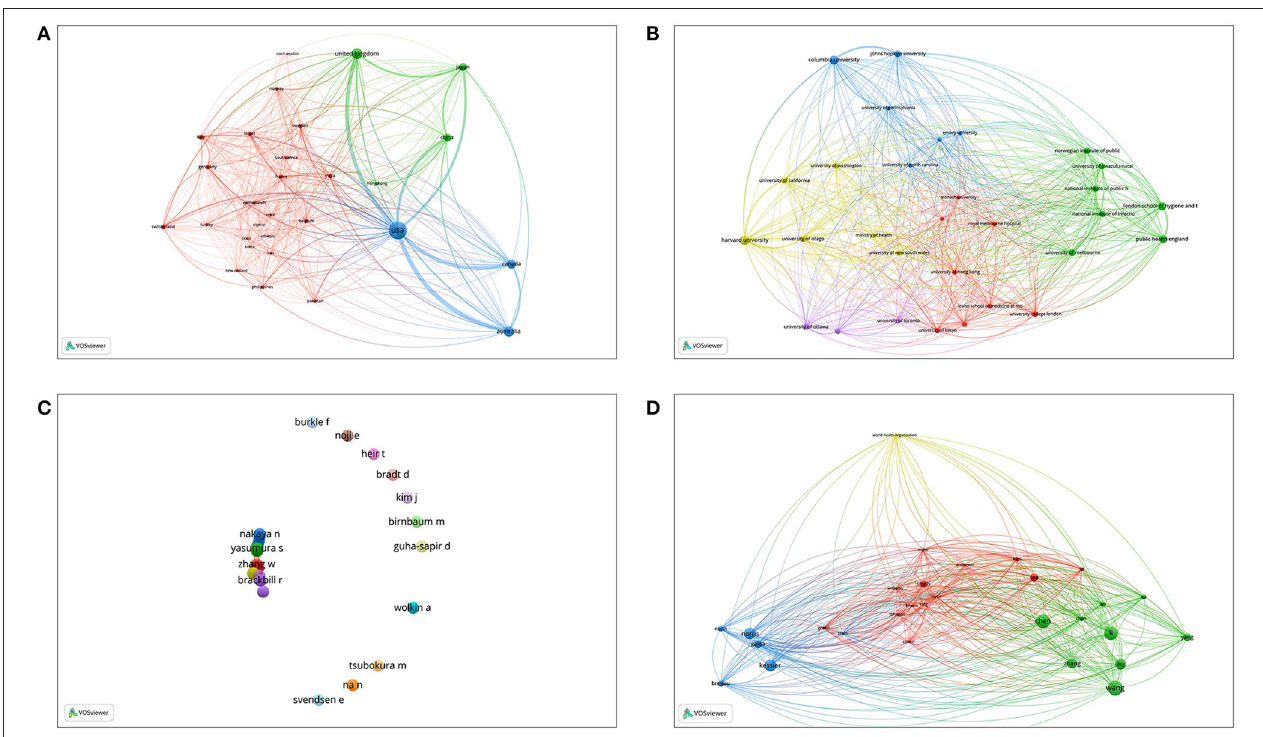
TABLE 2 | The top 10 most active journals that published articles on disaster epidemiology research.